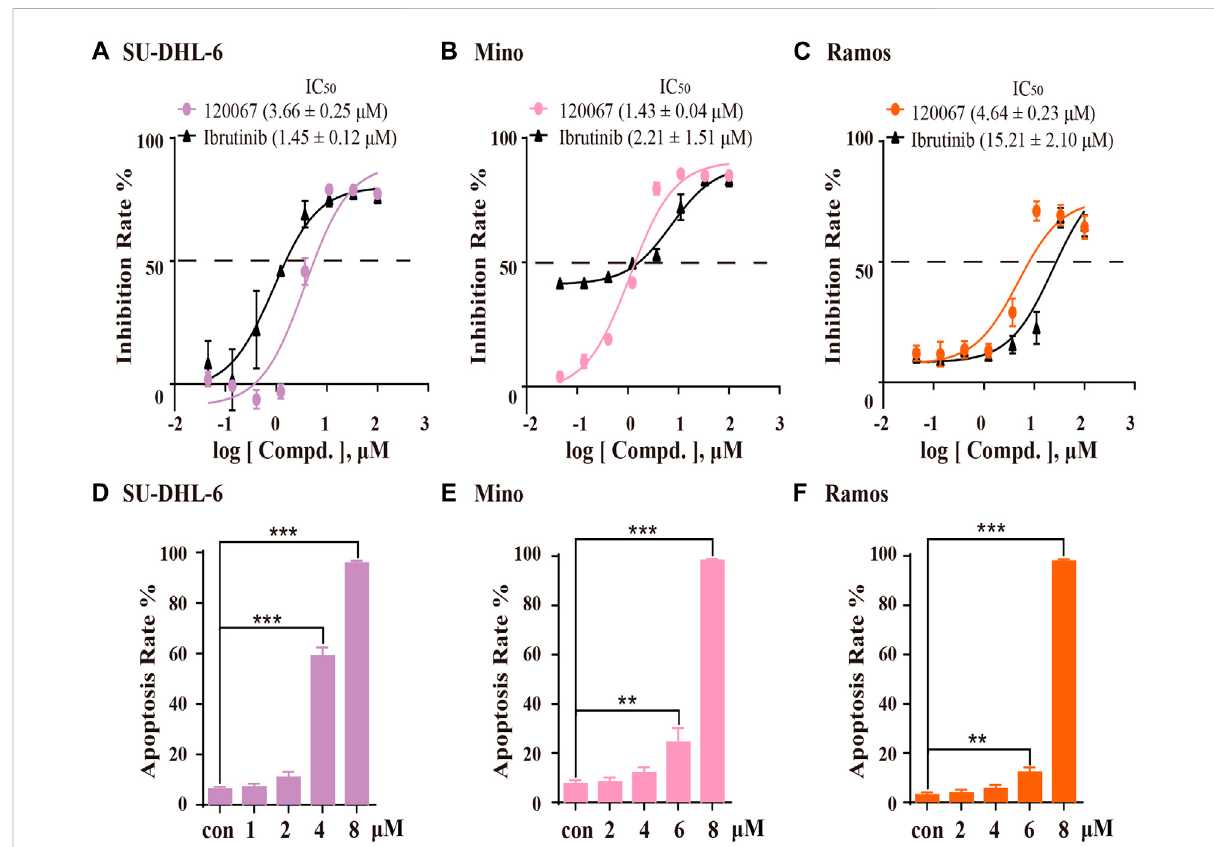
ASK120067 exhibited anti-proliferation and apoptosis-inducing activities in B-lymphoma cells. SU-DHL-6 (A) , Mino (B) , and Ramos (C) cells were incubated with various concentrations of ASK120067 or ibrutinib for 72 h, and then cell viability was measured using the MTT assay. Experiments were undertaken at least twice independently, and data are the mean ± SD. SU-DHL-6 (D) , Mino (E) , and Ramos (F) cell lines were seeded in six-well plates at 2.5 × 10 5 cells/well and treated with ASK120067 at indicated concentrations, and then apoptosis was analyzed